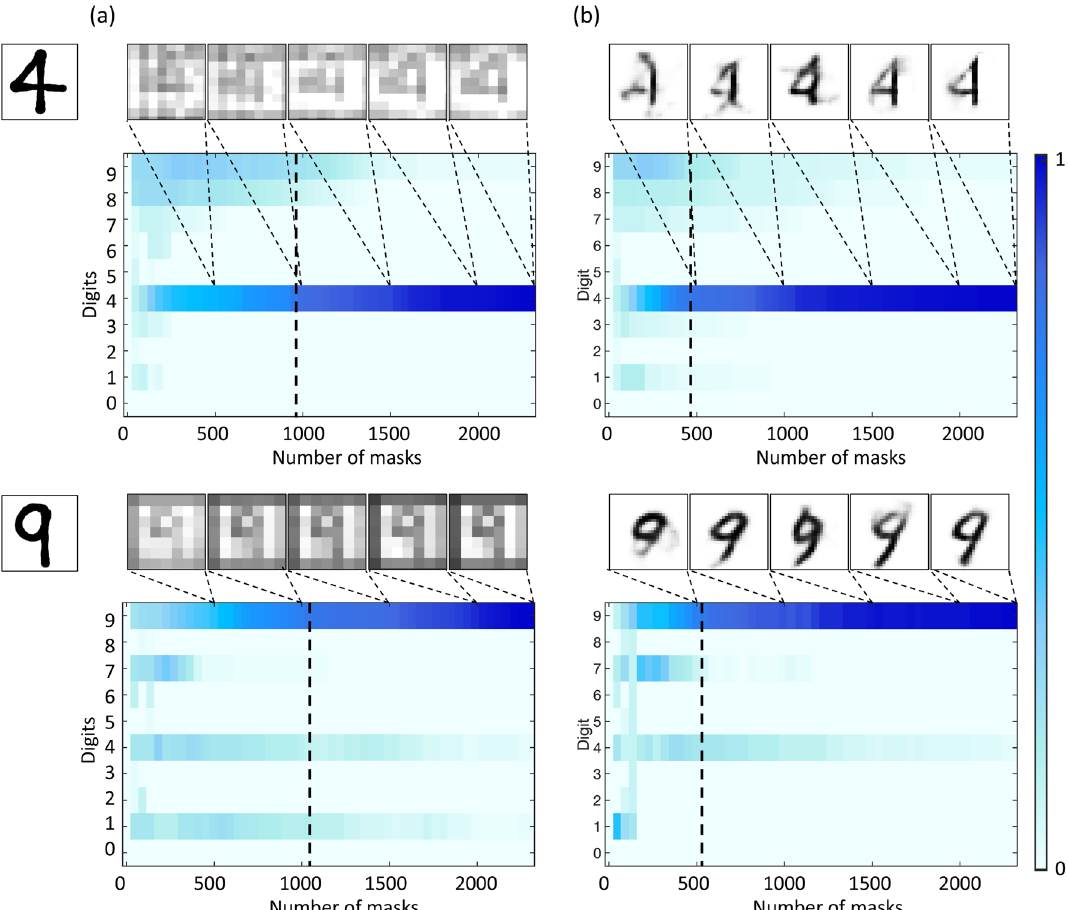
Figure 4. Results of the deep learning recognition algorithm and the two-step deep learning approach. ( a ) The reconstructed raw images for objects four and nine at 20, 40, 60, 80 and 100% image reconstruction time, respectively. Followed by the corresponding confidence predictions for all digits and iterations. ( b ) The aforementioned reconstructed raw images are then passed through the auto-encoder for image enhancement, displayed are the corresponding enhanced images at the same reconstruction times. Followed by the corresponding confidence predictions for all digits and iterations. A significant decrease in the reconstruction time between both cases is shown by the vertical dashed